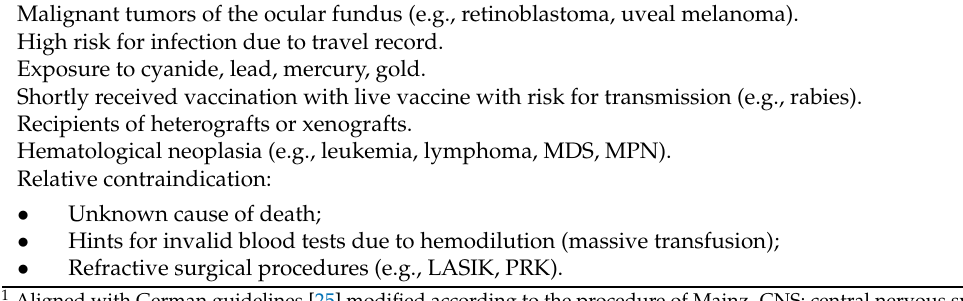
Table 1. Cont. Malignant tumors of the ocular fundus (e.g., retinoblastoma, uveal melanoma). High risk for infection due to travel record. Exposure to cyanide, lead, mercury, gold. Shortly received vaccination with live vaccine with risk for transmission (e.g., rabies). Recipients of heterografts or xenografts. Hematological neoplasia (e.g., leukemia, lymphoma, MDS, MPN).